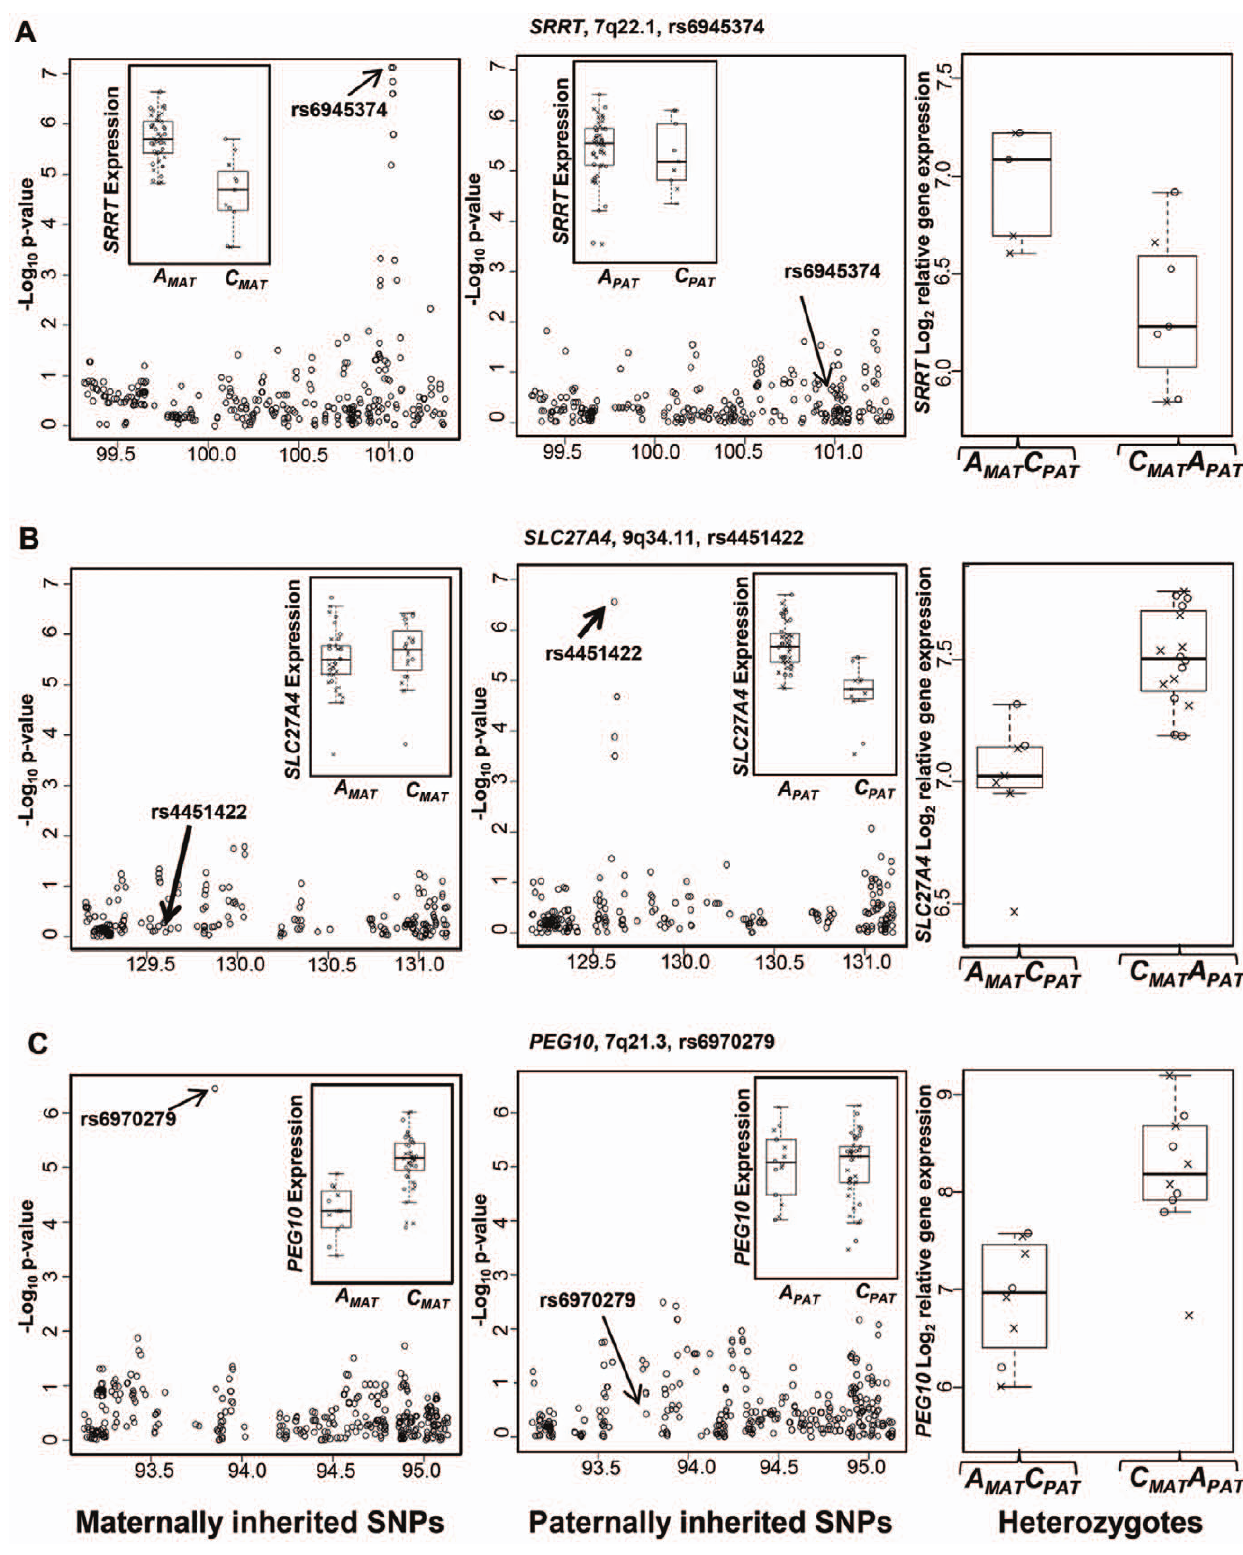
Figure 2. Putative cis -ieQTLs detected by parent of origin specific association analysis in 59 HapMap trios. Results for (A) SRRT and (B) SLC27A4 and (C) PEG10 . In each plot, the panels show the distribution of p-values for each SNP within a 6 1 Mb region around each gene based on separate association of the maternally- and paternally-inherited SNPs (left and middle panels respectively). The x-axis shows the genomic coordinates in Mb, and y-axis is the –log 10 p-value of association between each SNP allele of defined parental origin and gene expression level. Box plots show the distributions of gene expression for CEU ( circles ) and YRI offspring ( crosses ) with respect to maternally ( MAT ) and paternally ( PAT ) inherited SNPs. A